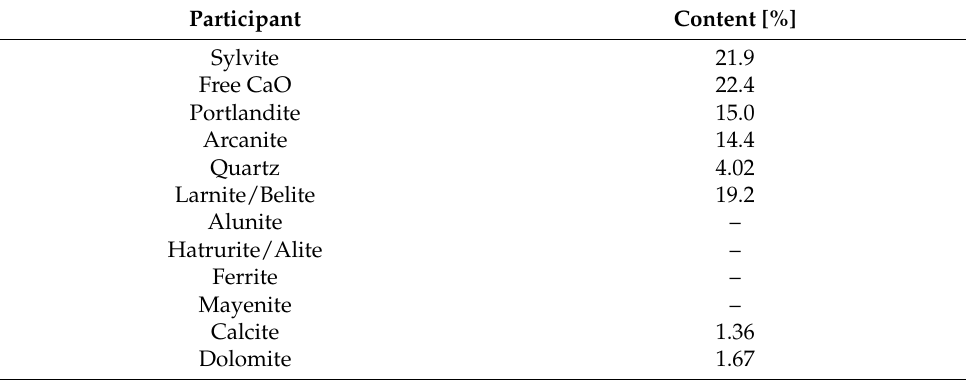
Figure 3. Mineralogical composition of CBPD determined by X-ray diffraction (XRD). Table 2. Cement by-pass dust composition (in wt. %) measured by XRD.